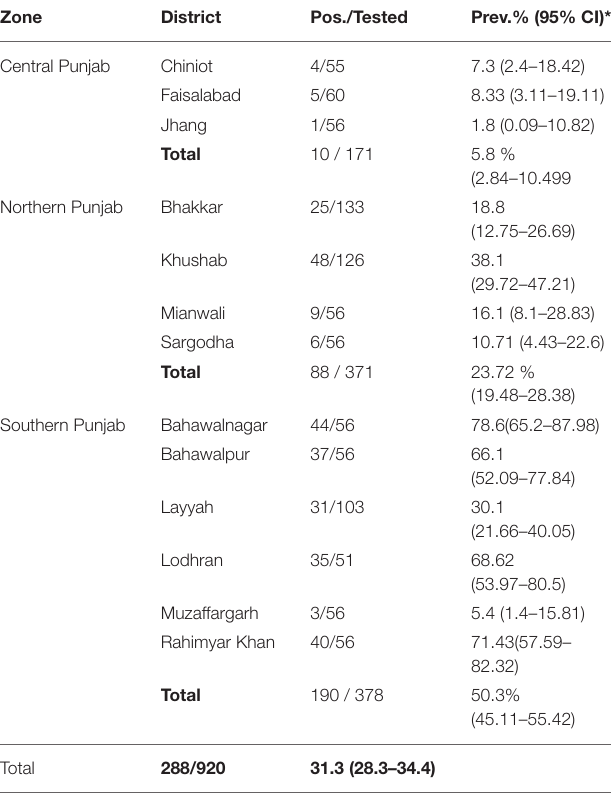
TABLE 2 | Prevalence of Q fever in camels in different ecological zones of Punjab Pakistan.